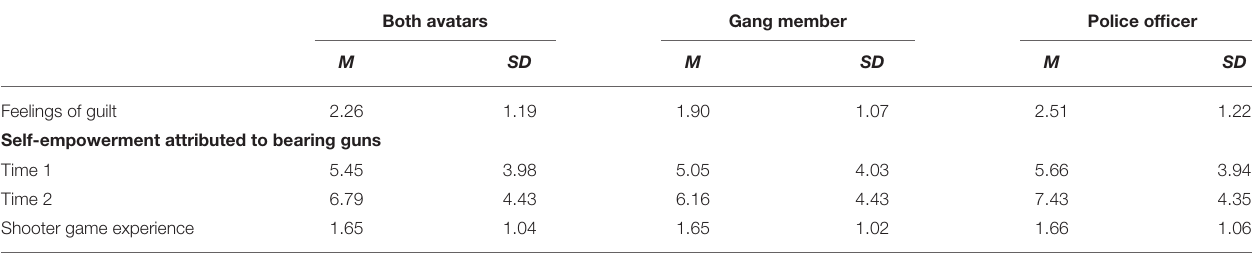
TABLE 2 | Descriptive statistics of the main variables of interest. Both avatars Gang